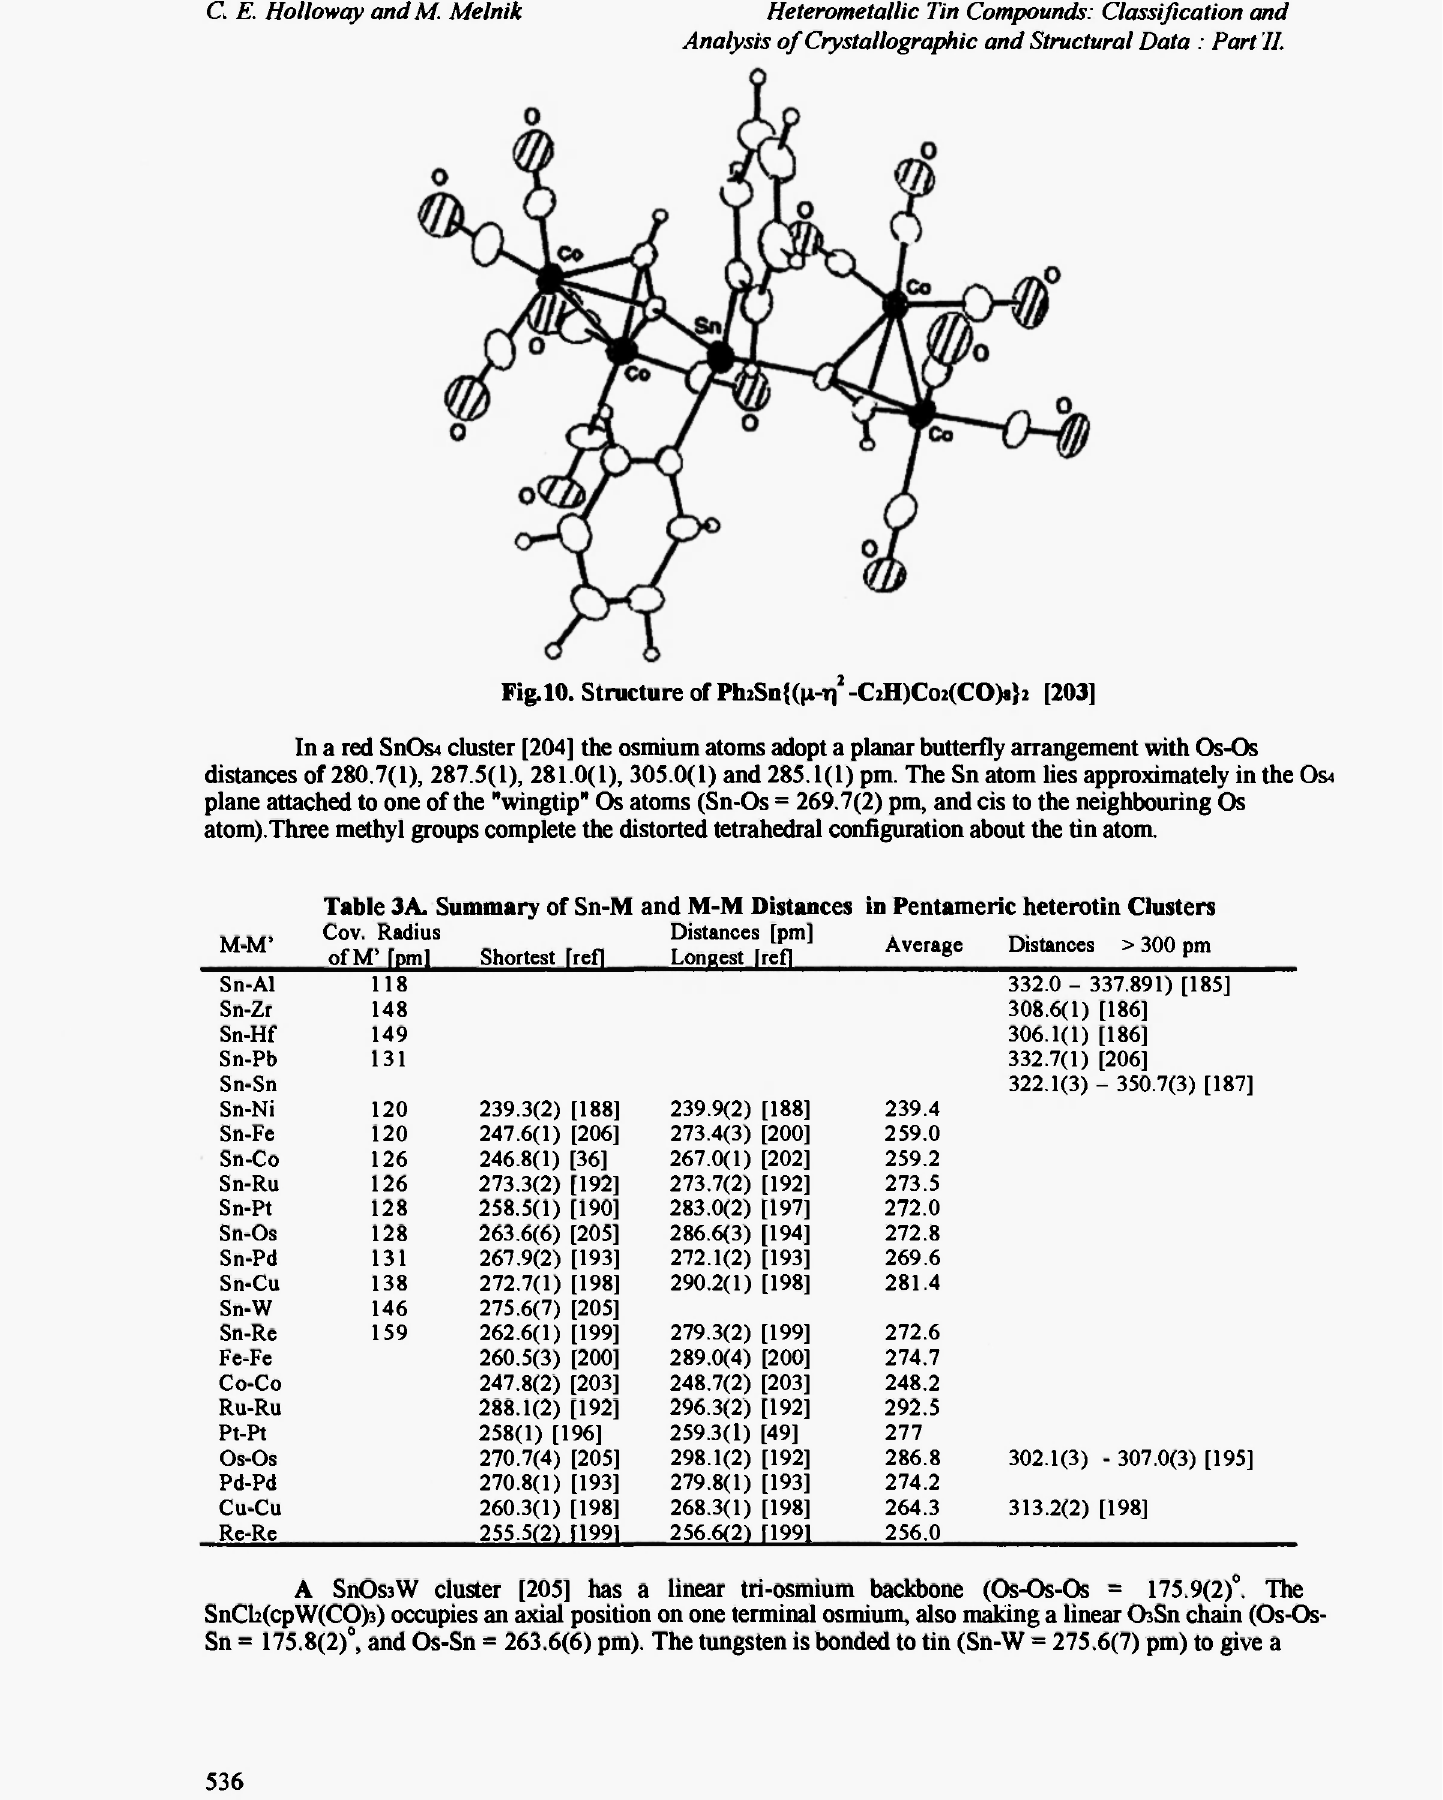
Table 3A. Summary of Sn-M and M-M Distances in Pentameric heterotin